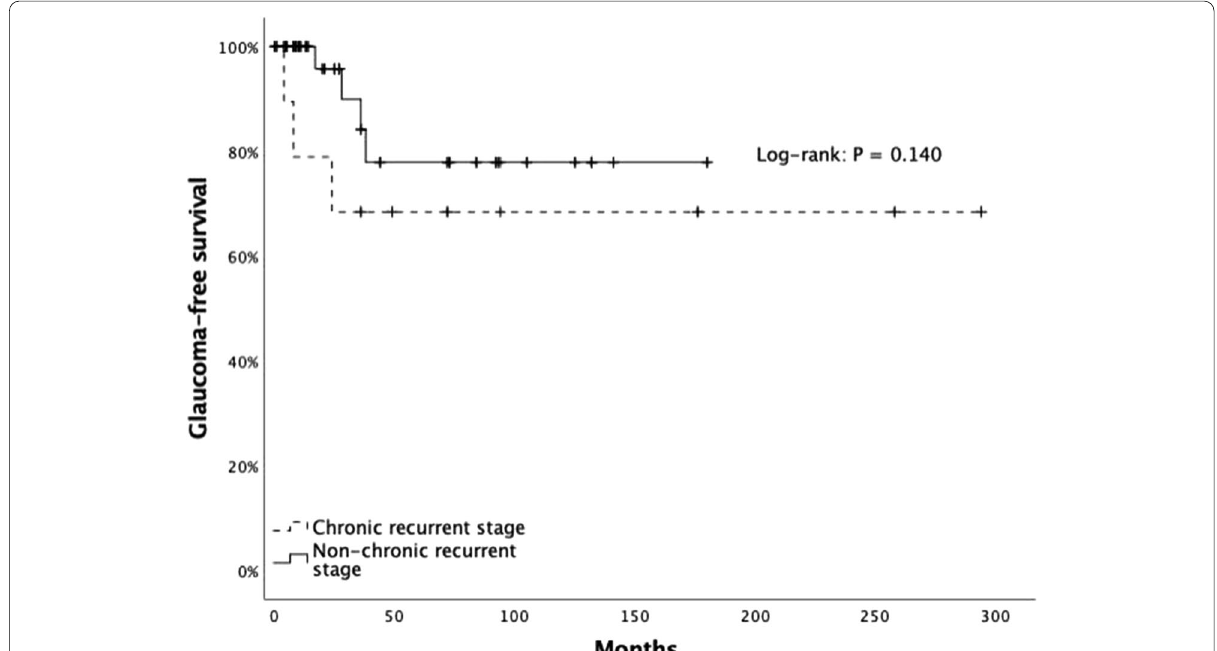
Fig. 1 Kaplan‑Meier plot of secondary glaucoma development based on the VKH phase at first visit. The incidence of glaucoma in patients with chronic‑recurrent VKH disease at one and two years were 22.1% and 31.6%, respectively. Patients with uveitis VKH disease had a risk of secondary glaucoma development of 22.1%. This difference was not significant ( p 0.140) =